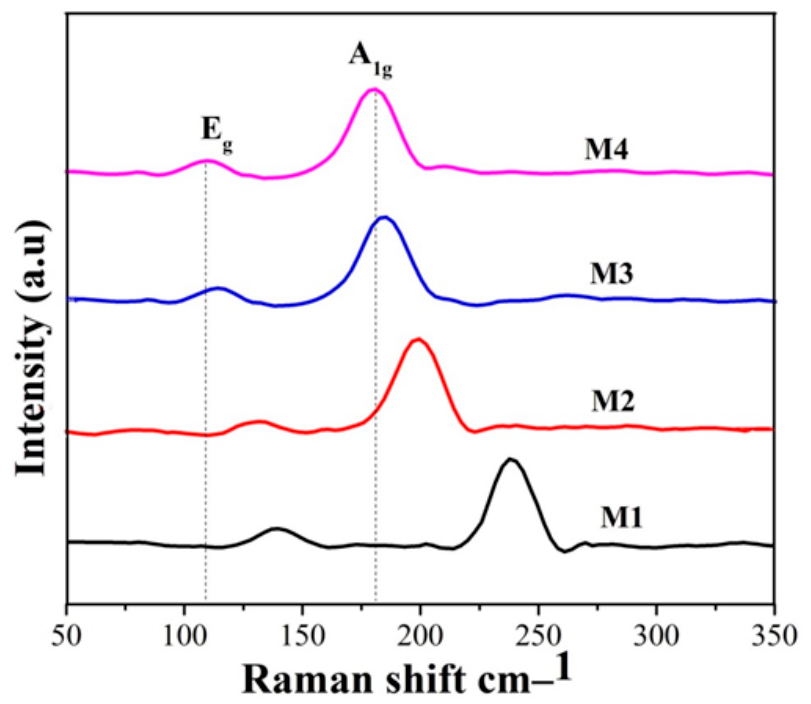
Figure 2. Raman spectra of SnSe 2 nano structured thin films calculated from 50 to 350 cm − 1 synthe- sized via thee solvothermal route. Eg and A1g represent the different molecular vibrations due to bonds present in the structure.